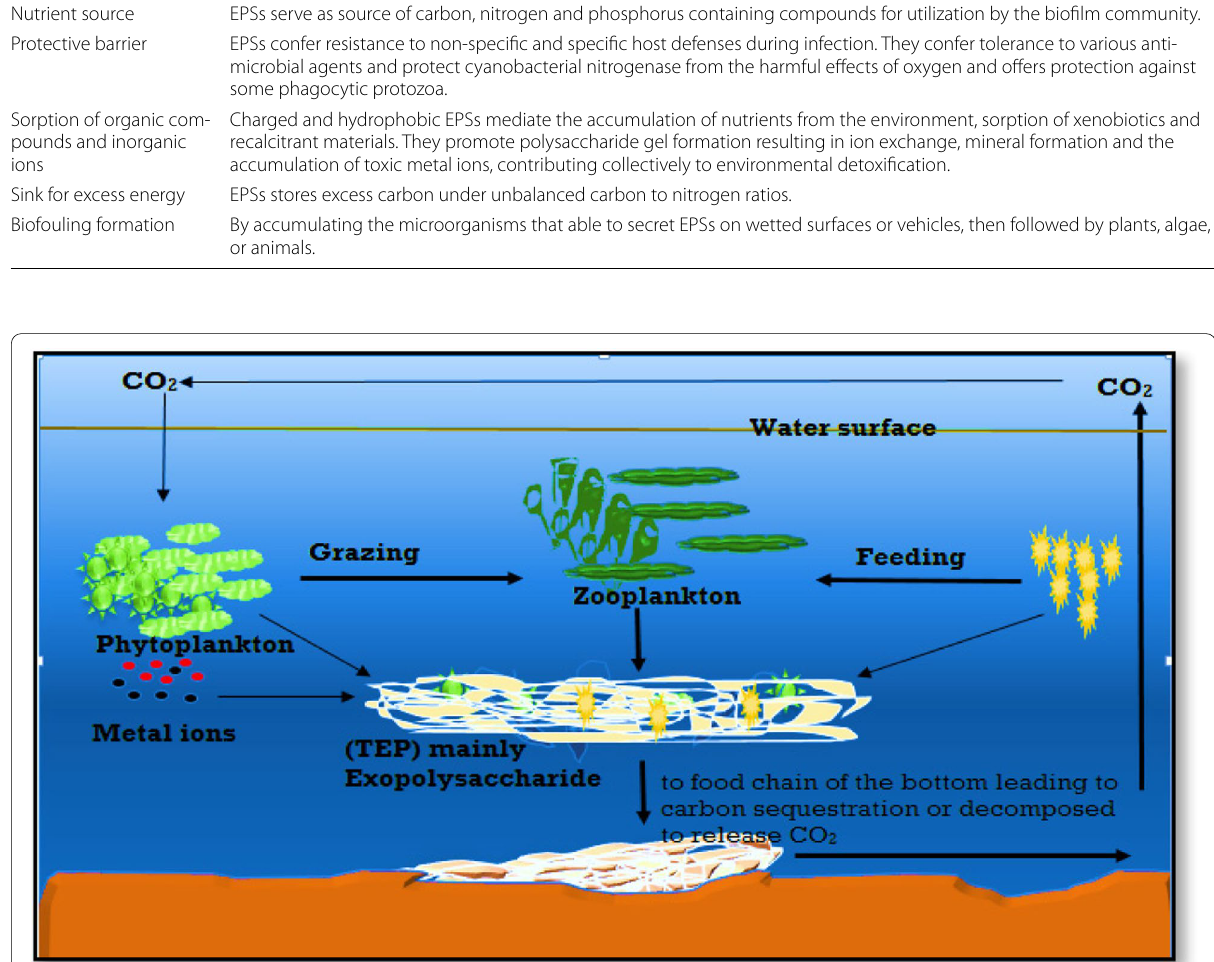
Table 1 A side of the roles accompanied to exopolysaccharides in the biofilms [105] Phenomenon Functions of EPSs related to biofilms Adhesion EPSs make provision for the initial steps in the colonization of surfaces by abiotic, biotic, and long‑term attachment of the biofilms. Bacterial cell aggregation The bridging between cells is enabled by EPSs, leading to the subsequent development of high cell densities and cell‑cell recognition.